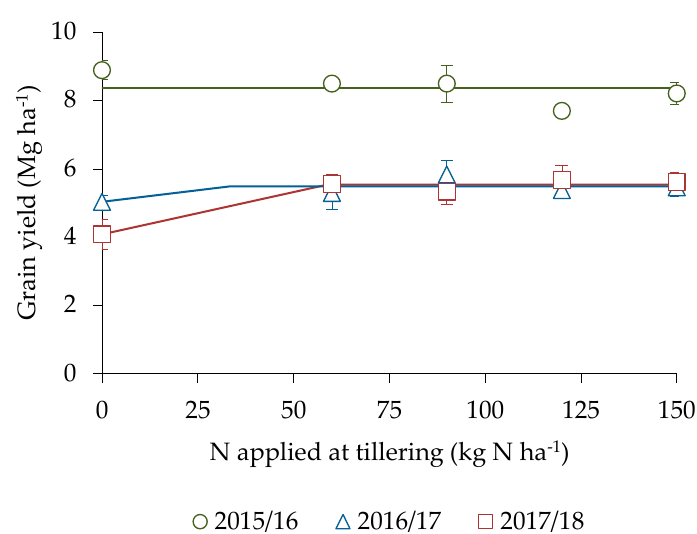
Figure 1. Grain yield response curves (linear-plateau model) to nitrogen application at tillering in the urea treatments in 2015 / 16, 2016 / 17, and 2017 / 18 seasons. Vertical bars indicate the standard error ( n = 4).